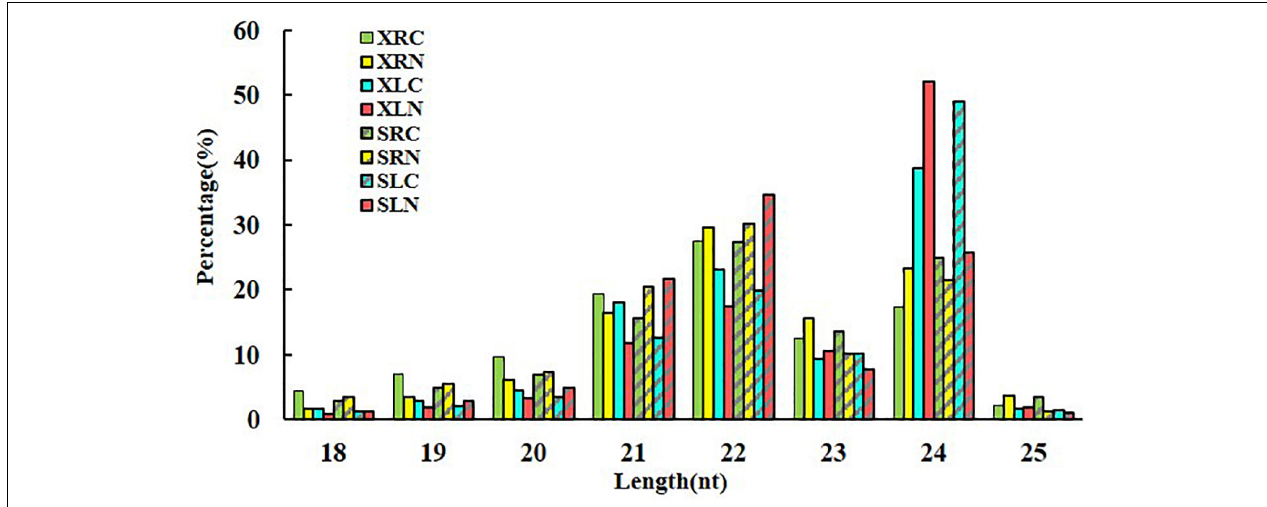
FIGURE 1 | Length distribution of small RNAs in two sweetpotato cultivars. XRC: “Xushu 22” root without NaCl treatment as control; XRN: “Xushu 22” root with NaCl treatment; XLC: “Xushu 22” leaf without NaCl treatment as control; XLN: “Xushu 22” leaf with NaCl treatment; SRC: “Xushu 32” root without NaCl treatment as control; SRN: “Xushu 32” root with NaCl treatment; SLC: “Xushu 32” leaf without NaCl treatment as control; SLN: “Xushu 32” leaf with NaCl